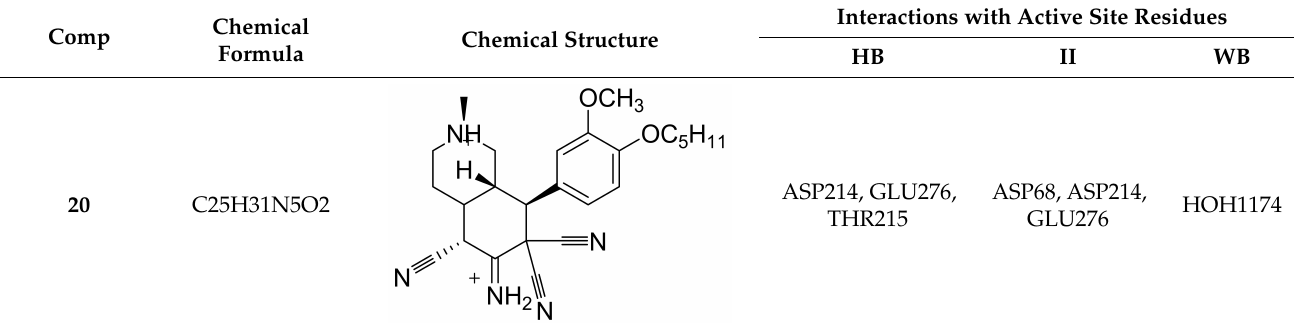
Table 2. The Chemical Structures and Binding Interactions of Eight